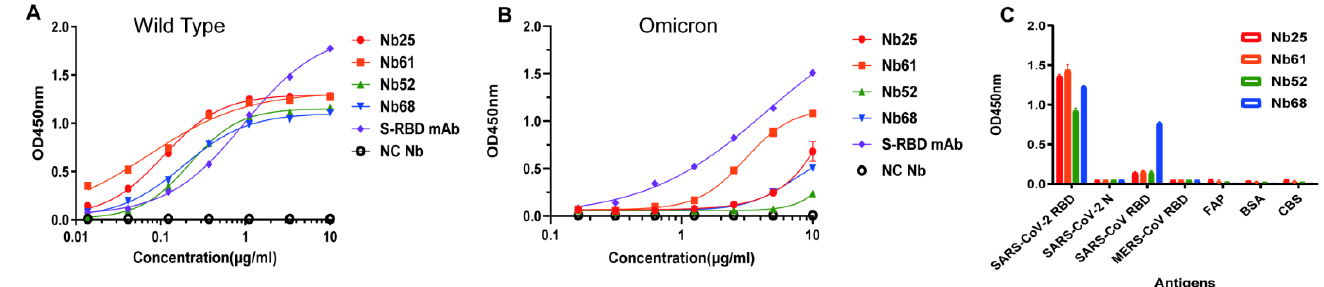
Figure 6. Indirect ELISA to identify the affinity of Nbs to SARS-CoV-2 S-RBD. ( A ) The binding affinity of Nbs to SARS-CoV-2 S-RBD (Wild Type); ( B ) the binding affinity of Nbs to SARS-CoV-2 S-RBD (Omicron); ( C ) the specificity of Nbs to SARS-CoV-2 S-RBD; commercial anti-SARS-CoV-2 RBD mAb was used as the positive control. The OD450 values were the means ± SD values from triplicate measurements.